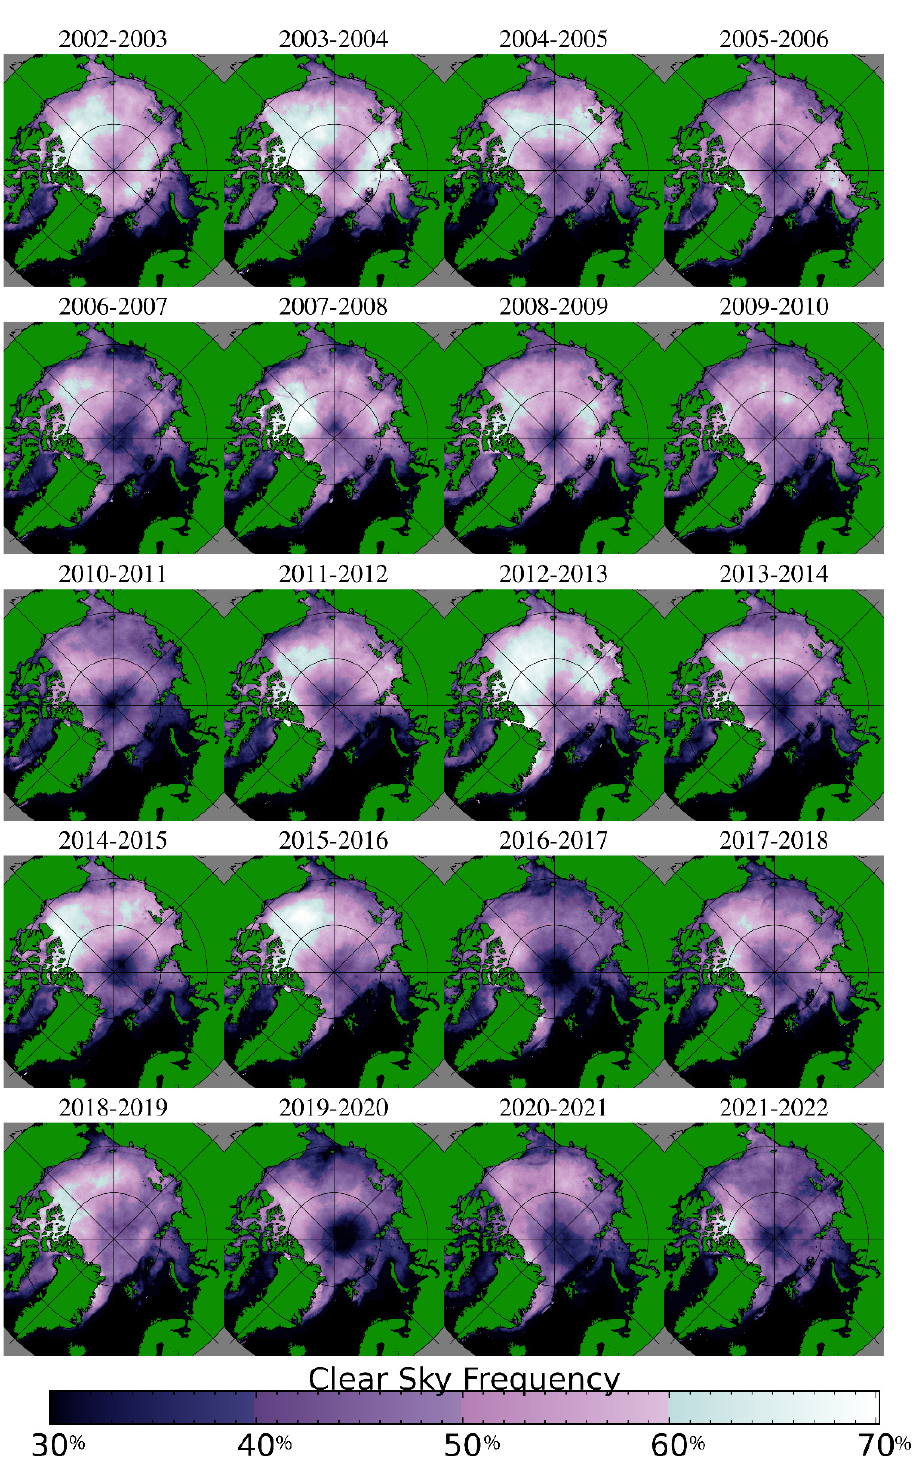
Figure 3. Winter clear sky frequency by year, reported as the percentage of probably clear or confidently clear overpasses in the MODIS cloud mask [32,33] divided by the number of total overpasses from November to April. Only overpasses over continuous sea ice are considered.